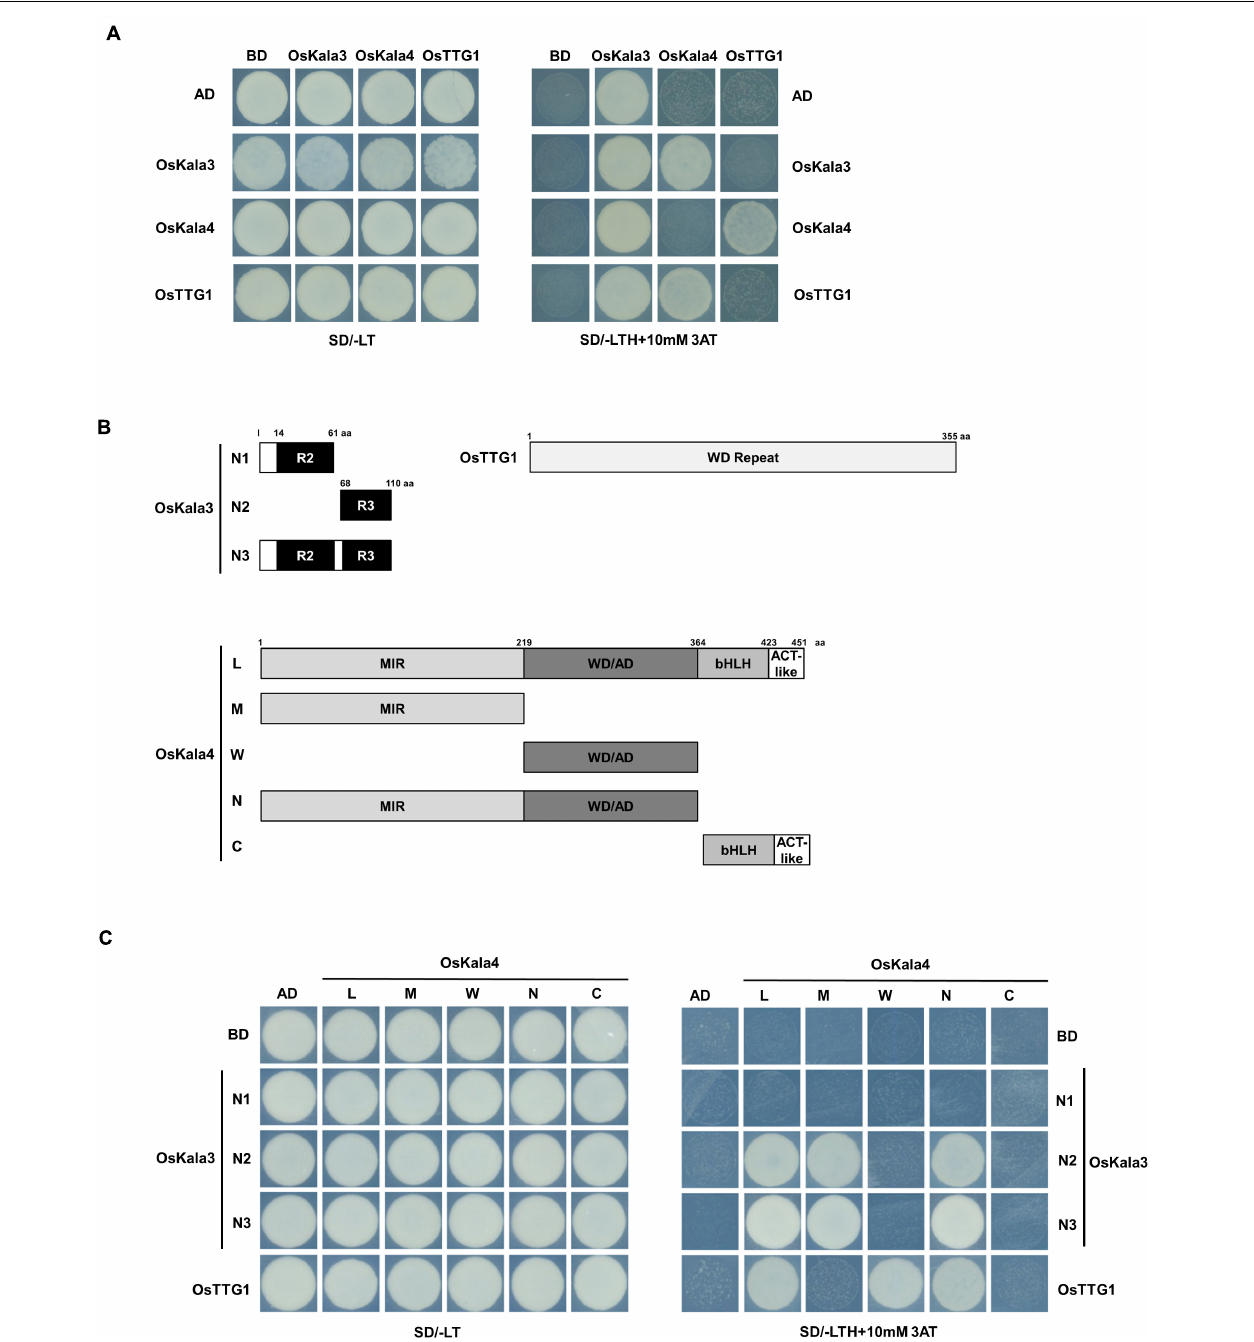
FIGURE 3 | OsKala3, OsKala4, and OsTTG1 form a ternary complex. (A) Interactions between OsKala3, OsKala4, and OsTTG1 proteins, as revealed by yeast two-hybrid (Y2H) analysis. (B) Schematic representation of constructs used to delineate the interaction interface between OsKala3, OsKala4, and OsTTG1. Amino acid positions are indicated in the diagrams. (C) Interactions between truncated OsKala3, OsKala4, and full-length OsTTG1. AD, activation domain; BD, binding domain; SD, synthetic defined medium; 3AT, 3-amino-1,2,4-triazole; SD/–TL, minimal medium lacking Trp and Leu; SD/–TLH + 3AT, synthetic defined medium lacking Trp, Leu, His and containing 10 mM